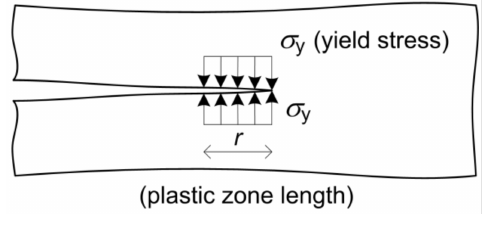
Figure 1. Idea of Dugdale model [6].